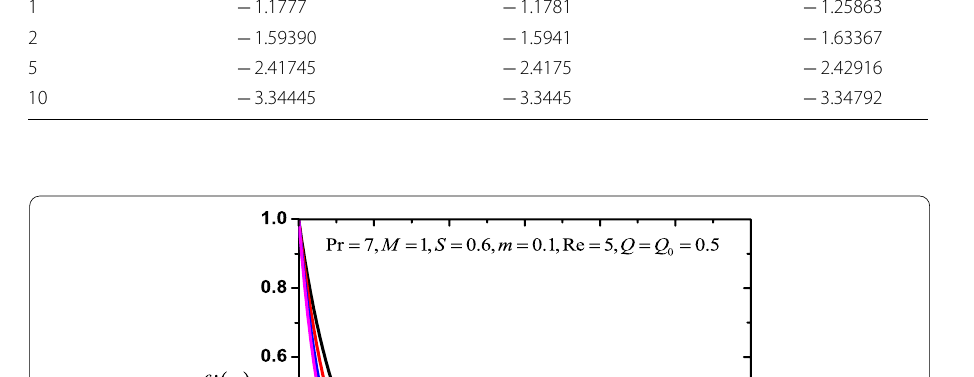
Table 2 Comparison of f ″ (1) for different values of Re when P Re Wang [2] Ishak et al. [3] Present results 0.5